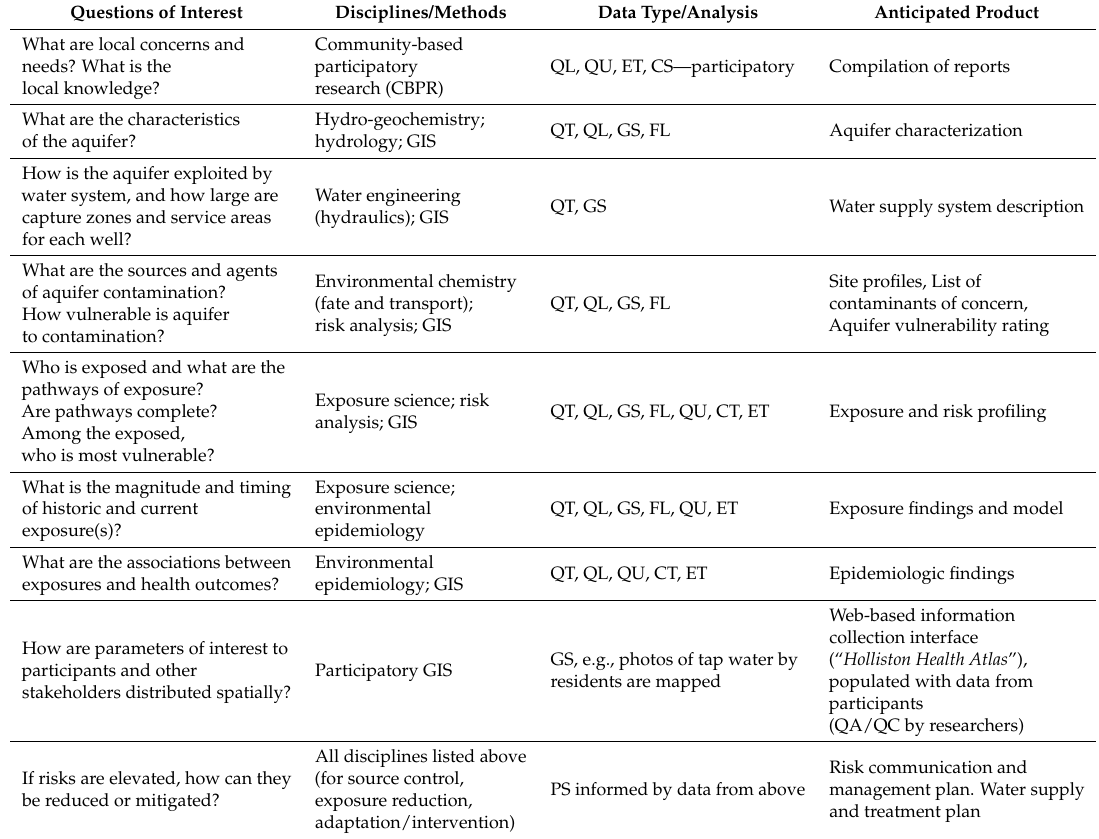
Table 1. Integrated approach to aquifer-based health risk